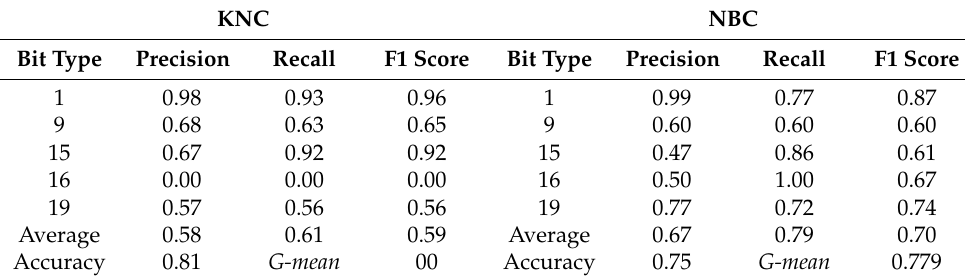
Table 8. The screening of 17.5” bits through KNC and NBC models.